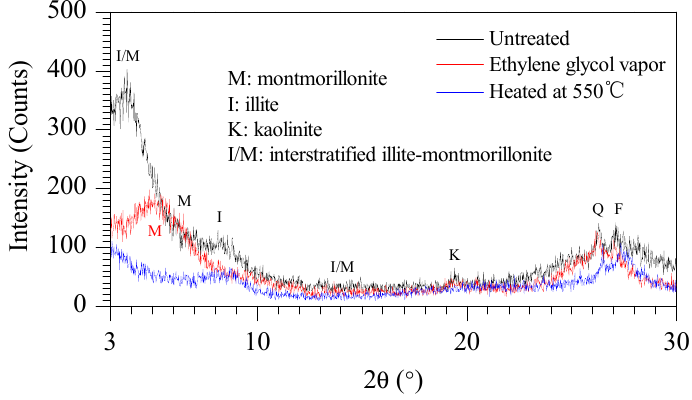
Figure 2. X-ray diffraction of a BCS sample. Table 1. Physical properties and cation exchange capacity (CEC) of BCS.